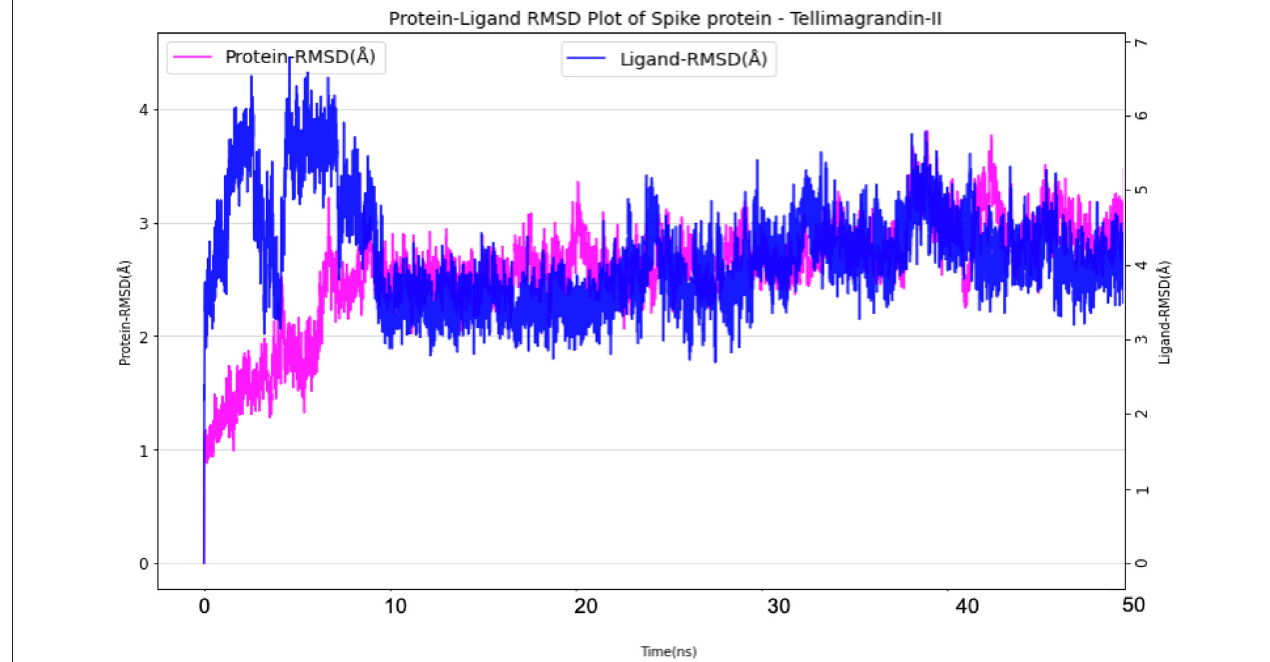
FIGURE 11 | Protein-Ligand RMSD plots of Spike protein Tellimagrandin-II